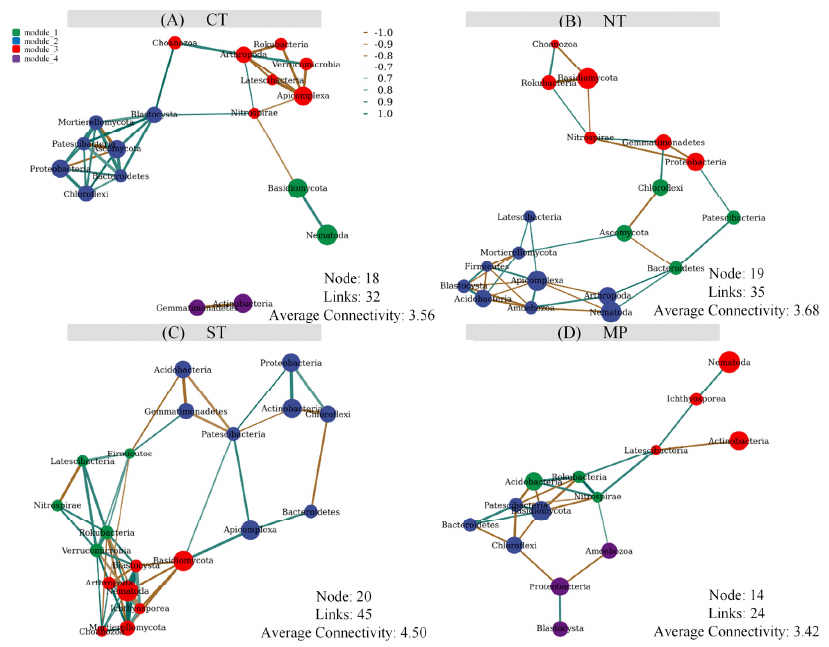
Figure 5. Network visualization of the interaction strengths within soil microbial and faunal com- munity structure. CT, Rotary and ridge tillage; NT, No-tillage; ST, Subsoil tillage; MP, Moldboard plowing tillage. n = 24 (four treatments, three replications per treatment, and two soil depths). Agronomy 2022 , 12 , 2356